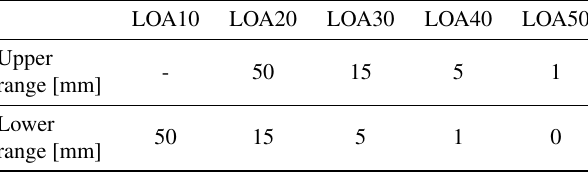
Table 1. BIM and building documentation specifications